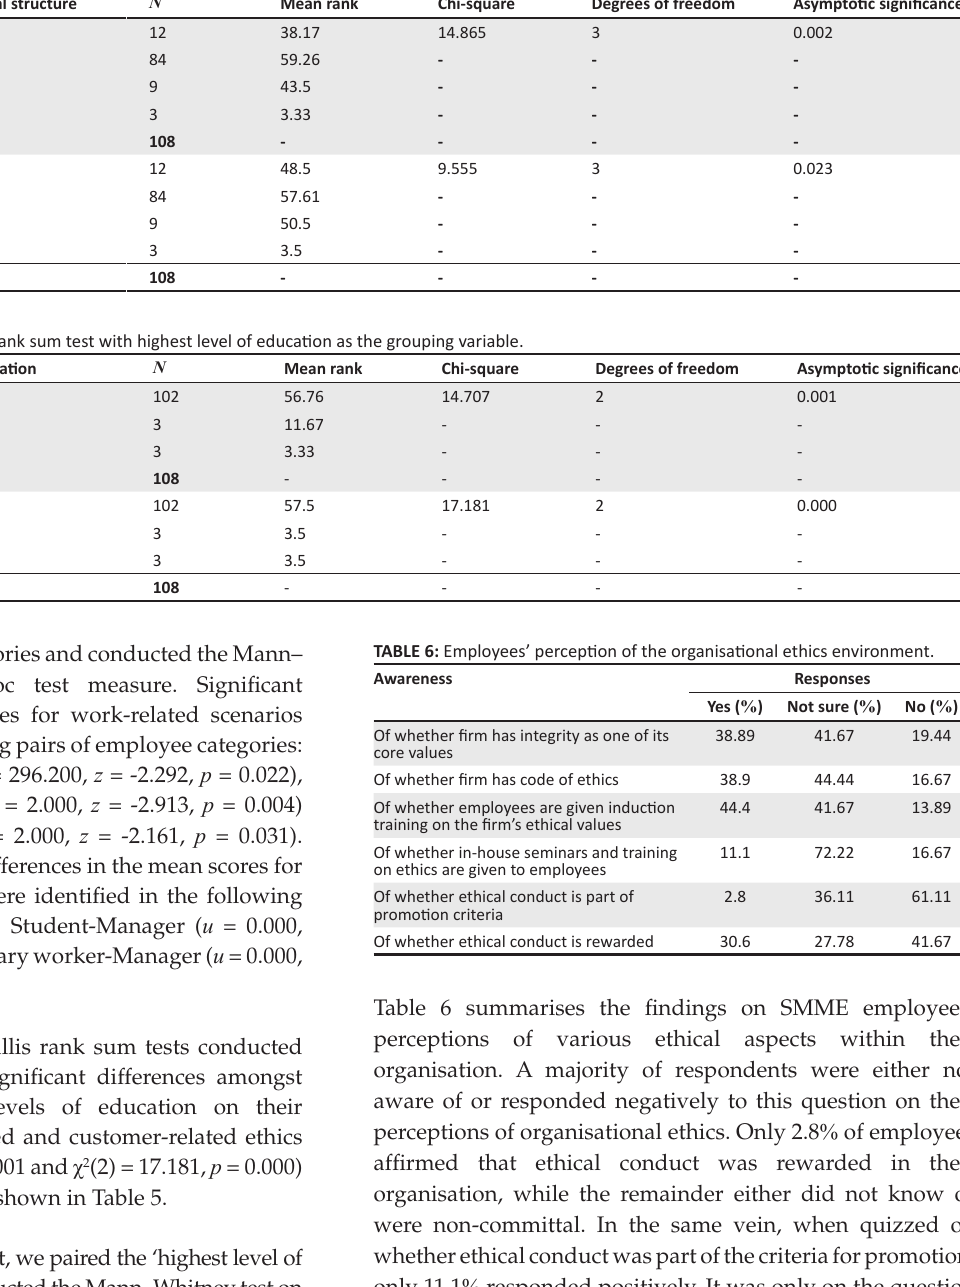
TABLE 4: Results of the Kruskal–Wallis rank sum test with level in the organisational structure as the grouping variable.